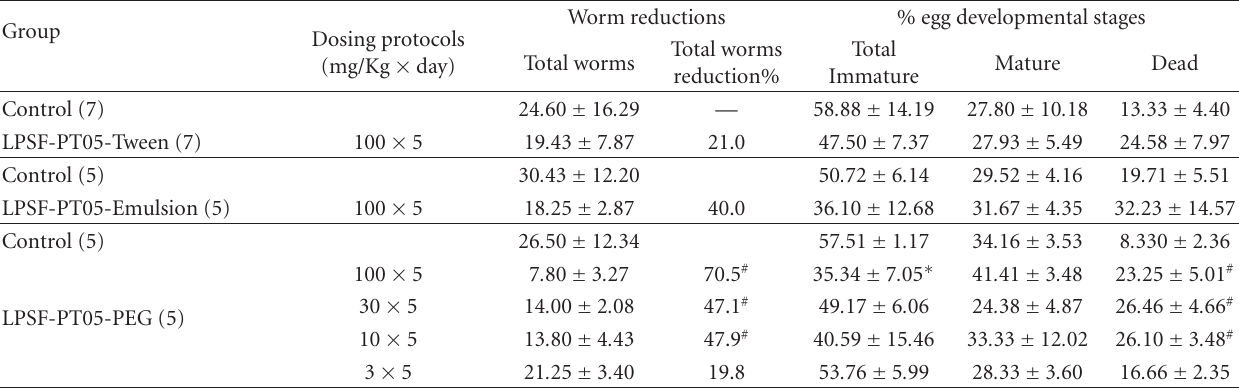
Table 1: E ff ect of di ff erent formulations of LPSF-PT05 on worm burdens and oogram patterns in experimentally infected mice harbouring adult S. mansoni (BH